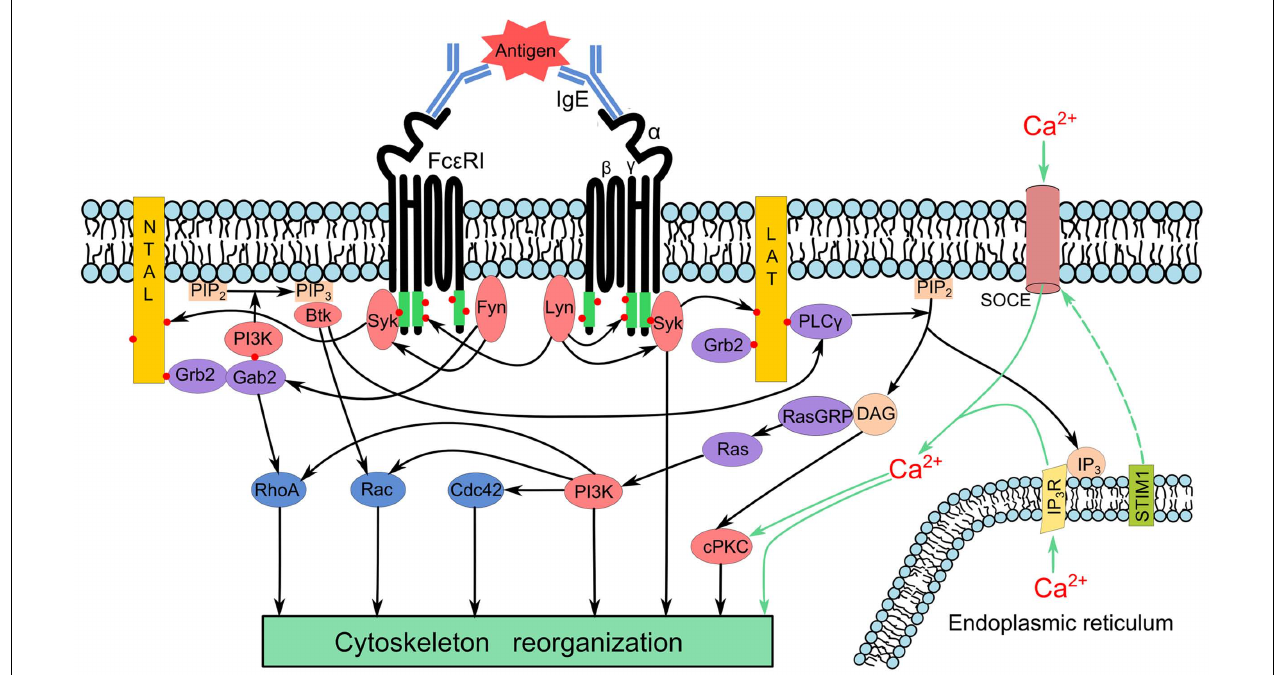
FIGURE 1 | Simplified model of early signaling events leading to cytoskeleton reorganization after Fc ε RI aggregation. Aggregation of the Fc ε RI by multivalent antigen induces activation of the Src kinase Lyn, which phosphorylates (red dots) ITAM motifs of Fc ε RI β and γ subunits (green), followed by anchoring of the Syk kinase to Fc ε RI through interaction of Syk-SH2 domains with phosphorylated ITAMs. Aggregation also leads to activation of Fyn kinase that phosphorylates the adaptor Gab2. Transmembrane adaptor proteins NTAL and LAT are phosphorylated by Syk giving rise to formation of binding sites for various SH2-containing proteins such as Grb2. In this way it brings Gab2 and phosphoinositide-3-kinase (PI3K) to the membrane. Activated PI3K phosphorylates phosphatidylinositol- 4,5-biphosphate (PIP 2 ) to yield phosphatidylinositol-3,4,5-triphosphate (PIP 3 ), a binding site for